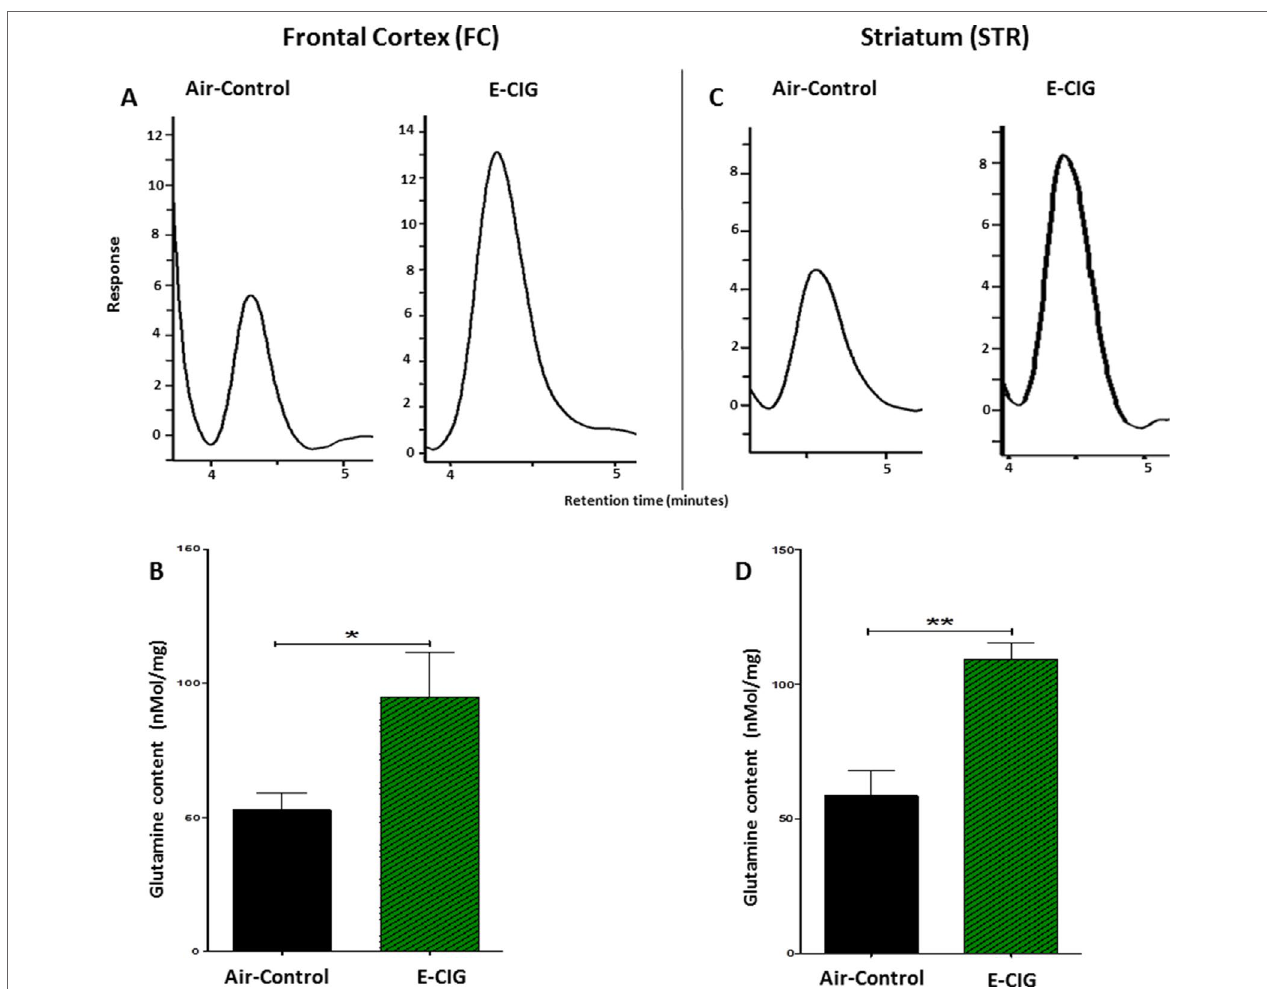
FIGURE 4 | Effects of inhalation of E-CIG for 6 months on glutamine concentrations in the FC and STR in male C57BL/6 mice. (A) Peaks of glutamine in the FC in air control and E-CIG groups. (B) Independent t -test analysis revealed a marked increase in glutamine concentration in the FC in E-CIG vapor–exposed group as compared to the controls. (C) Peaks of glutamine in the STR in air control and E-CIG groups. (D) Independent t -test analysis revealed a marked increase in glutamine concentration in the STR in E-CIG vapor–exposed group compared to air controls. Data are reported as mean ± SEM (** p < 0.01,* p < 0.05) ( n = 5 for each group), ( X -axis, retention time [minutes], Y -axis,